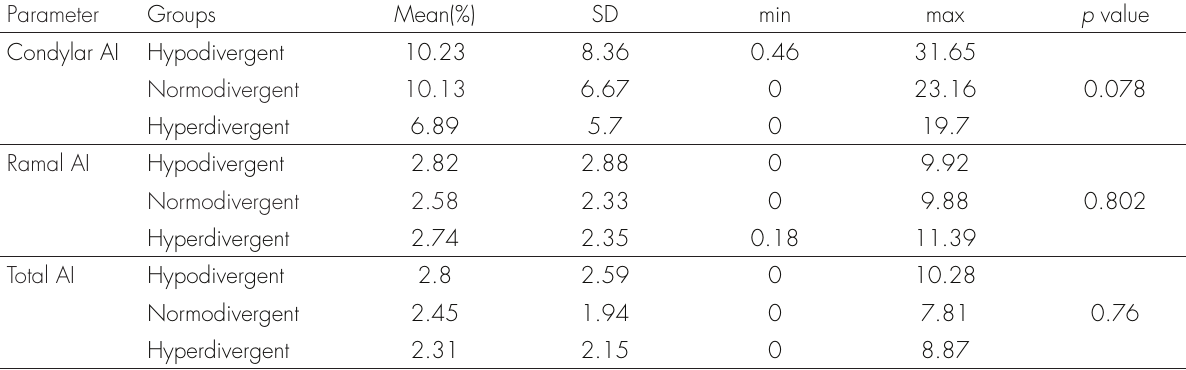
Table IV. The relationships between the AI values and the vertical skeletal